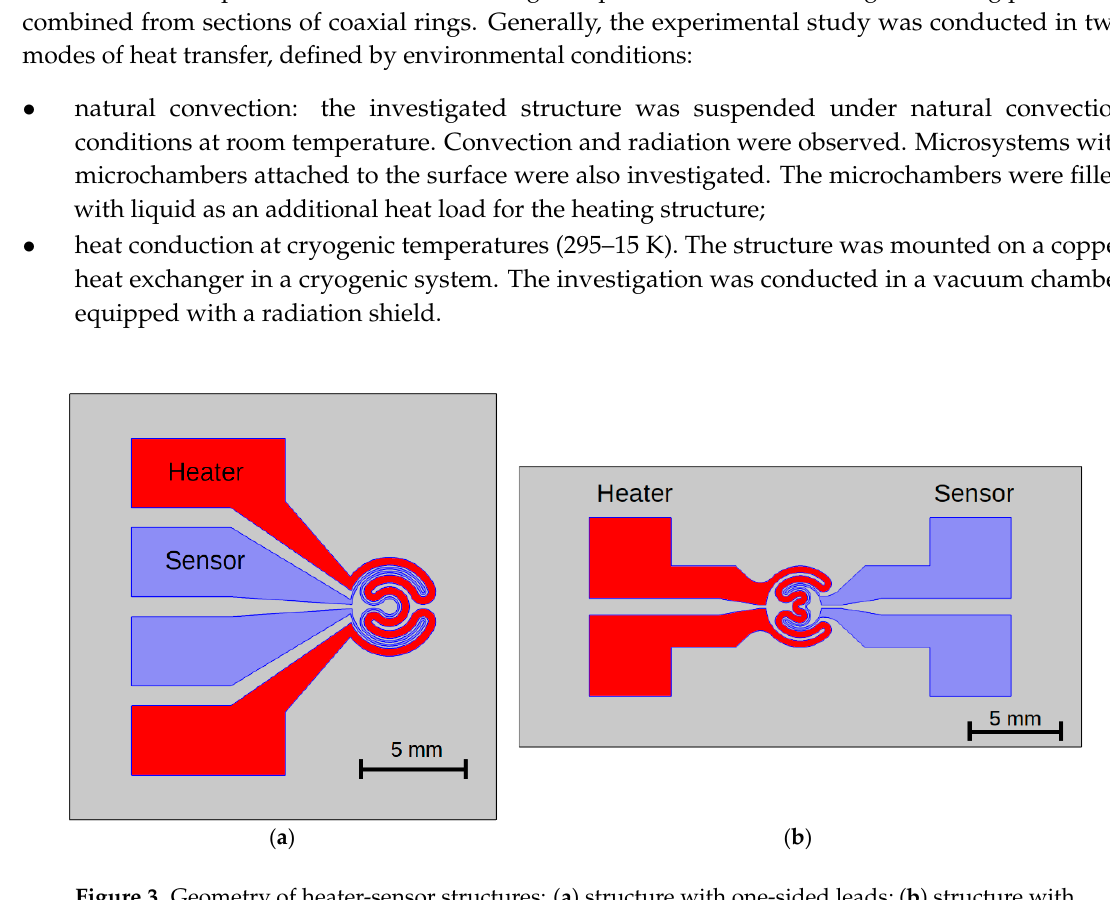
Figure 3. Geometry of heater-sensor structures: ( a ) structure with one-sided leads; ( b ) structure with two-sided leads .